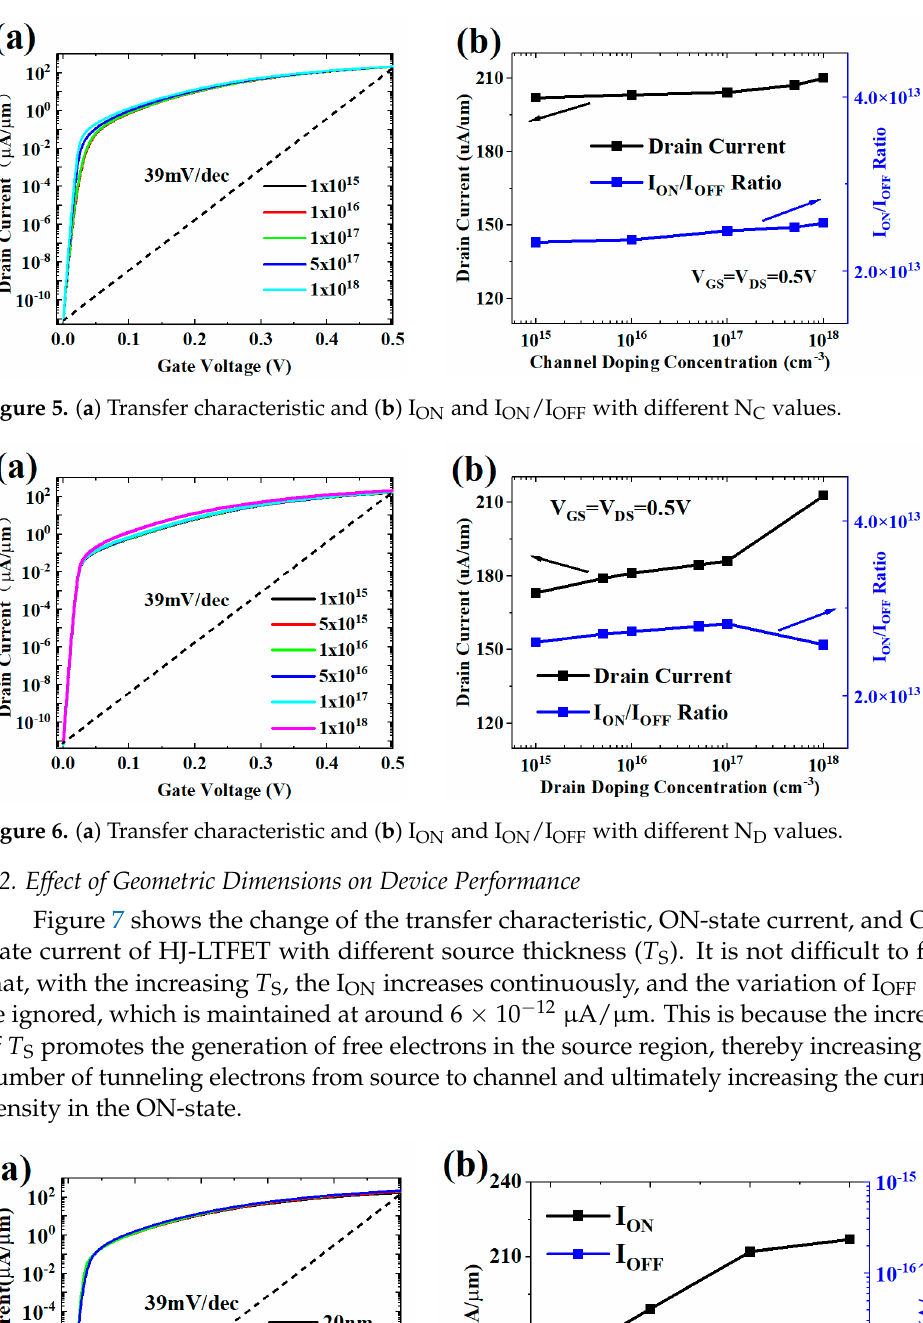
Figure 8. ( a ) Transfer characteristic and ( b ) I ON and I ON / I OFF with different T C values. Figure 9 compares the effect of traditional low-doped spacer layer and modified HFO2 barrier layer with varying thickness between the source and drain on suppressing SDT leakage in OFF-state. It is not hard to find, in Figure 9a, that the SDT phenomenon (consisting of source-to-drain horizontal tunneling and source-to-drain diagonal tunnel- ing) of the traditional structure in OFF-state is particularly serious. After the HfO2 barrier layer is used, the OFF-state electron tunneling on the horizontal direction of source and drain is completely suppressed, which shows that the performance of the modified struc- ture has been greatly improved. For the diagonal tunneling between source and drain, the OFF-state leakage can be further reduced by increasing the thickness of the barrier layer, as shown in Figure 9b. This is because the increased barrier thickness weakens the drain voltage and increases the barrier height of SDT. At the same time, the I ON marginally de- clines as the barrier layer’s thickness increases.